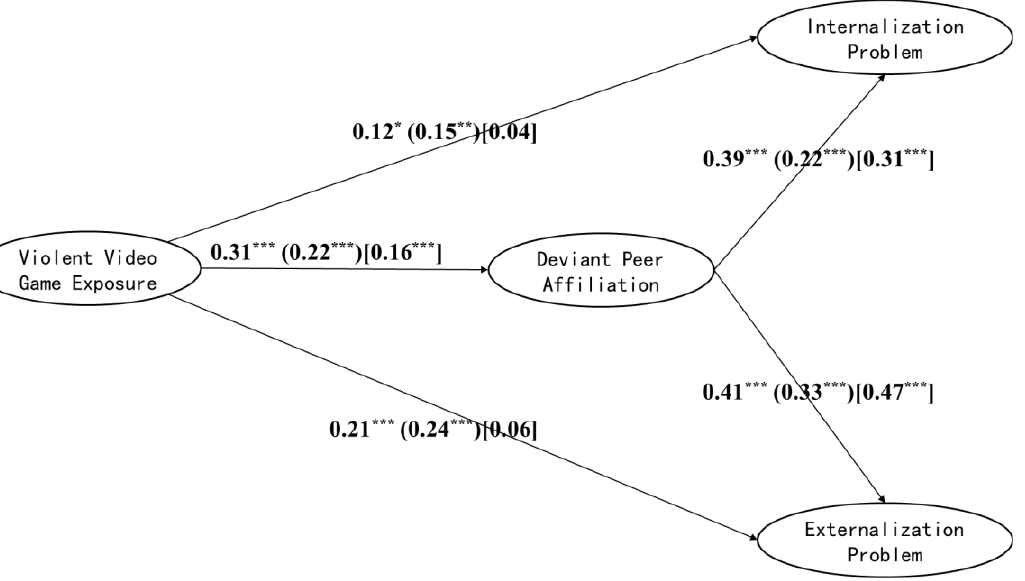
Figure 3. Grade differences in mediating role of deviant peer affiliation. Note: Path coefficients outside parentheses are for elementary school, inside parentheses are for junior high school, and inside square brackets are for senior high school. The load coefficient between each latent variable and its index, the residual error and error of all variables, and the control variable coefficient are omitted to simplify the model. * p < 0.05, ** p < 0.01, *** p < 0.001.